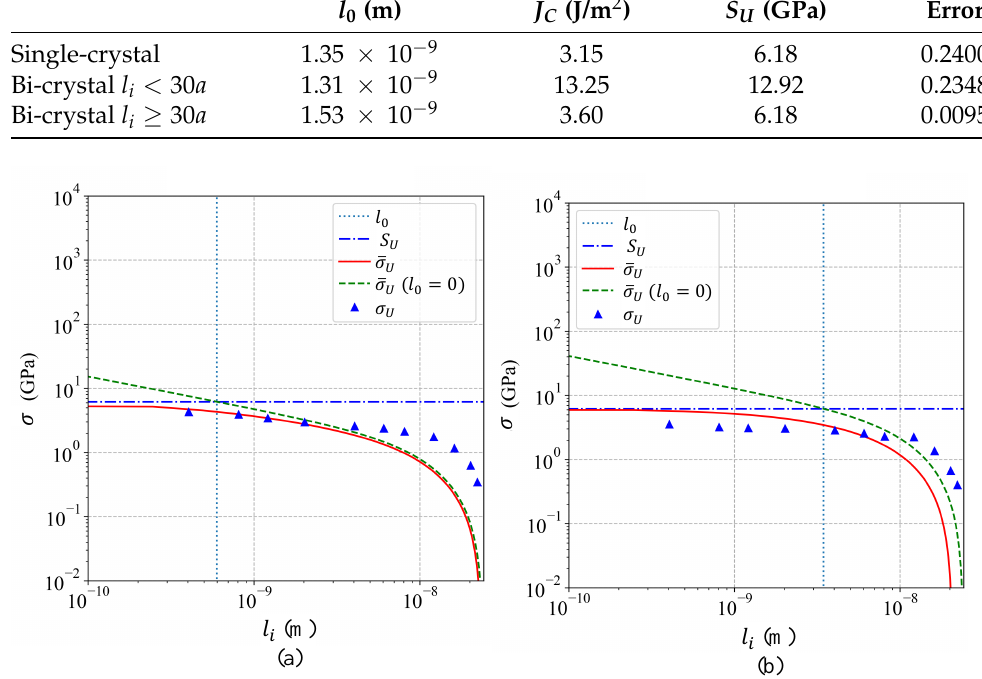
Figure 6. Model based on the LEFM parameter K I and virial stress tensor ( a ) for single-crystals Al and ( b ) for bi-crystals Al.